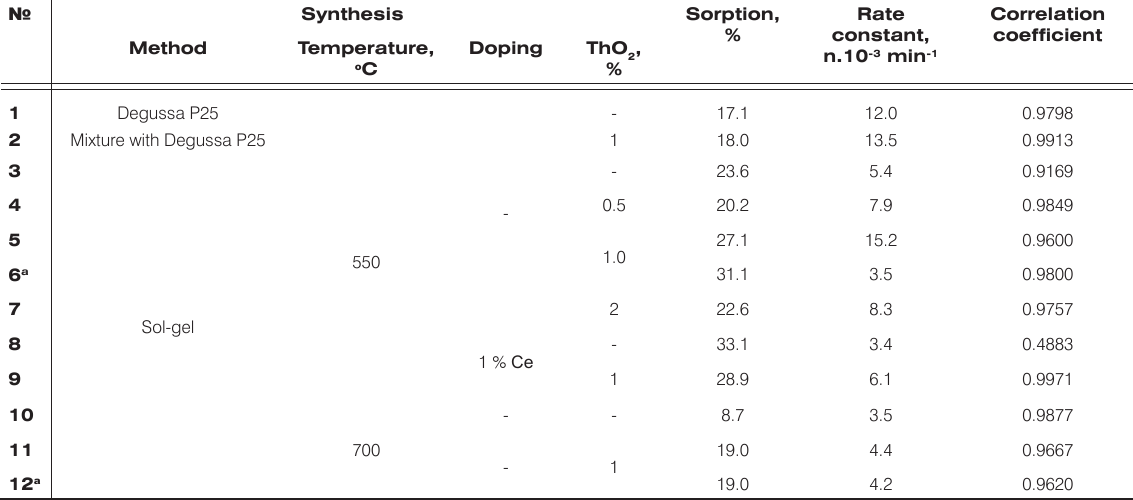
Table 2. Sorption ability and photocatalytic activity of the studied samples.